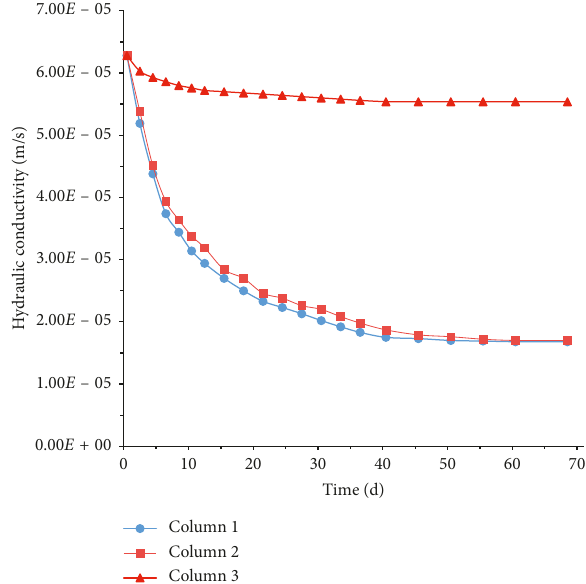
Figure 4: Changes in hydraulic conductivity as function of time.